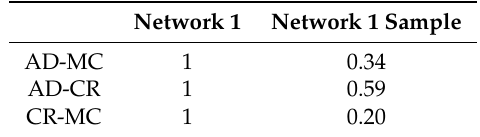
Table 4. Comparison of the analysis results of MDND on the sparse network with the administrative divisions and community detection